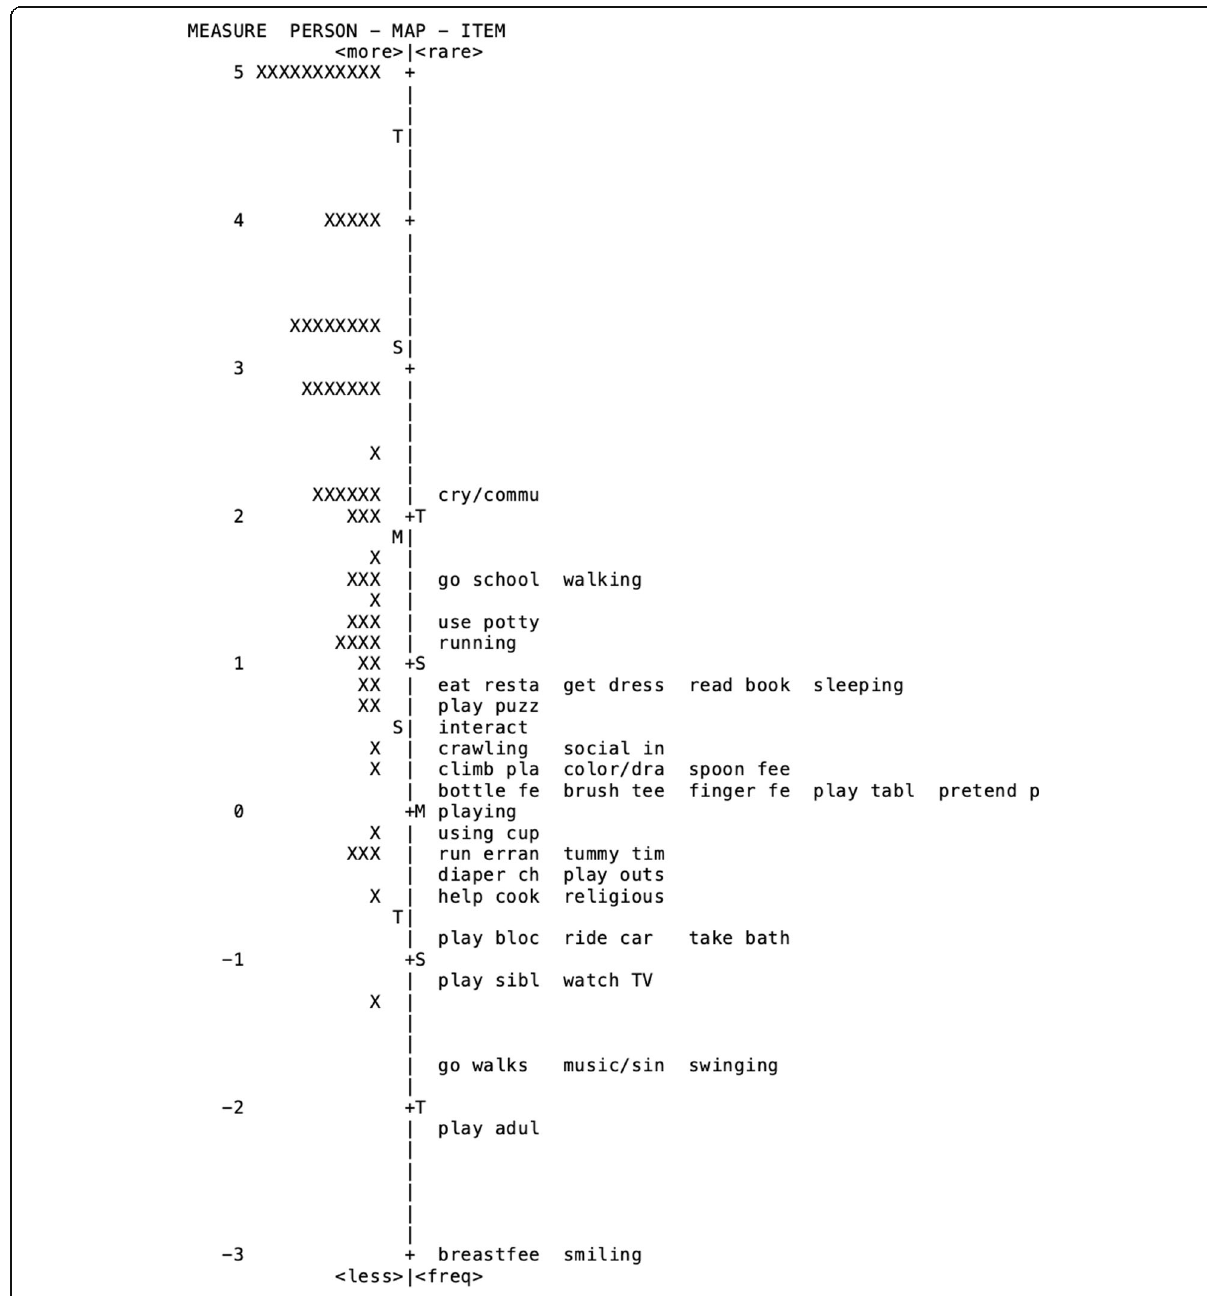
Fig. 2 Wright Map of Participants and Items